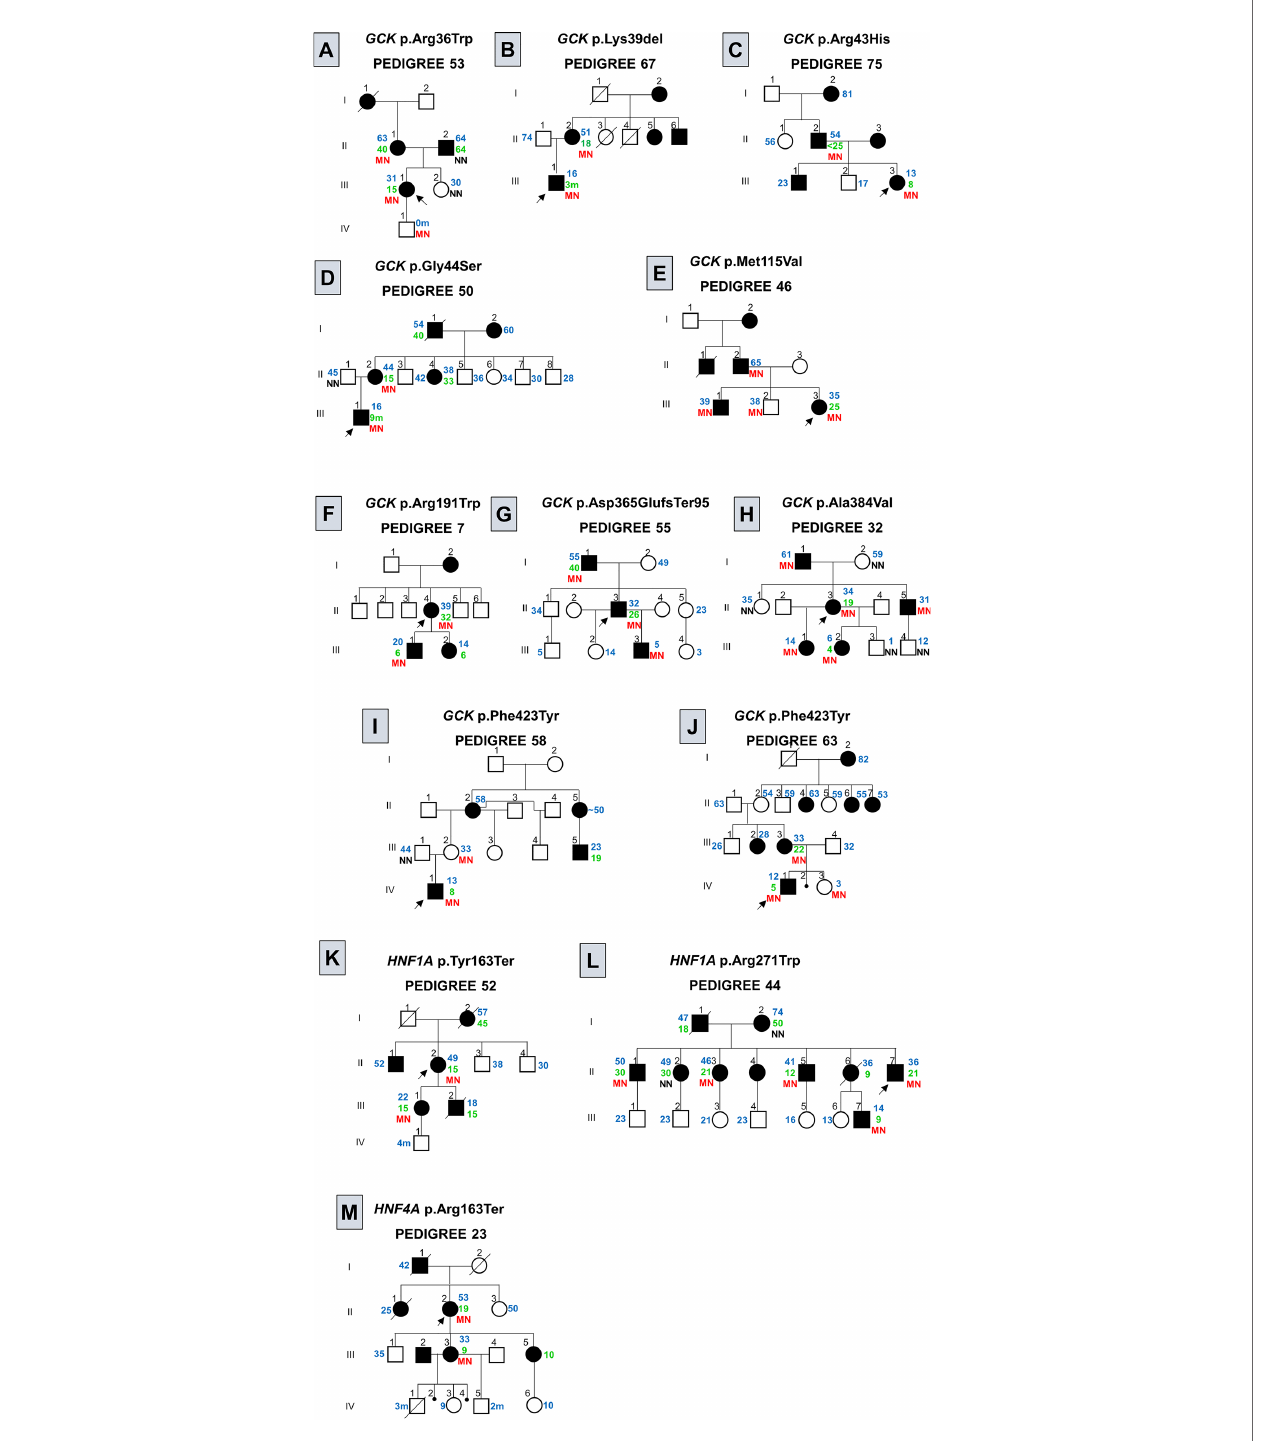
FIGURE 2 | Pedigree of families with variants in genes associated to monogenic diabetes. Filled black symbols, grey symbols and empty symbols represent diabetic patients, impaired tolerance glucose patients and healthy individuals, respectively. Small black circles represent miscarriage [ (J) , individual IV-2; (M) , individuals IV-2 and IV-4]. The present age of the individuals are show in blue and age at diagnosis in green, both are represent in years or months (m) when the age is followed by the (M) . Genotypes are expressed by homozygous normal allele (NN) and heterozygous mutated allele (MN) in red. Oblique lines through symbols represent deceased individuals. An arrow indicates the index case. In the pedigree 75 (C) < 25 indicates that the AAD was prior to the AAD usually observed for clinical criteria for MODY. In the pedigree 58 (I) the age of the individual II-5 was informed to be approximately (~) 50 years old. In the pedigree 23 (M) the family reported that the subject III-2 was diagnosed with MODY, although we are not able to con fi rm this